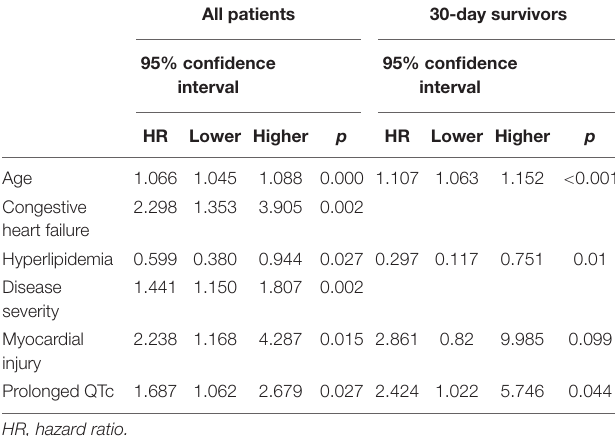
TABLE 3 | Multivariate Cox regression for 1-year mortality.